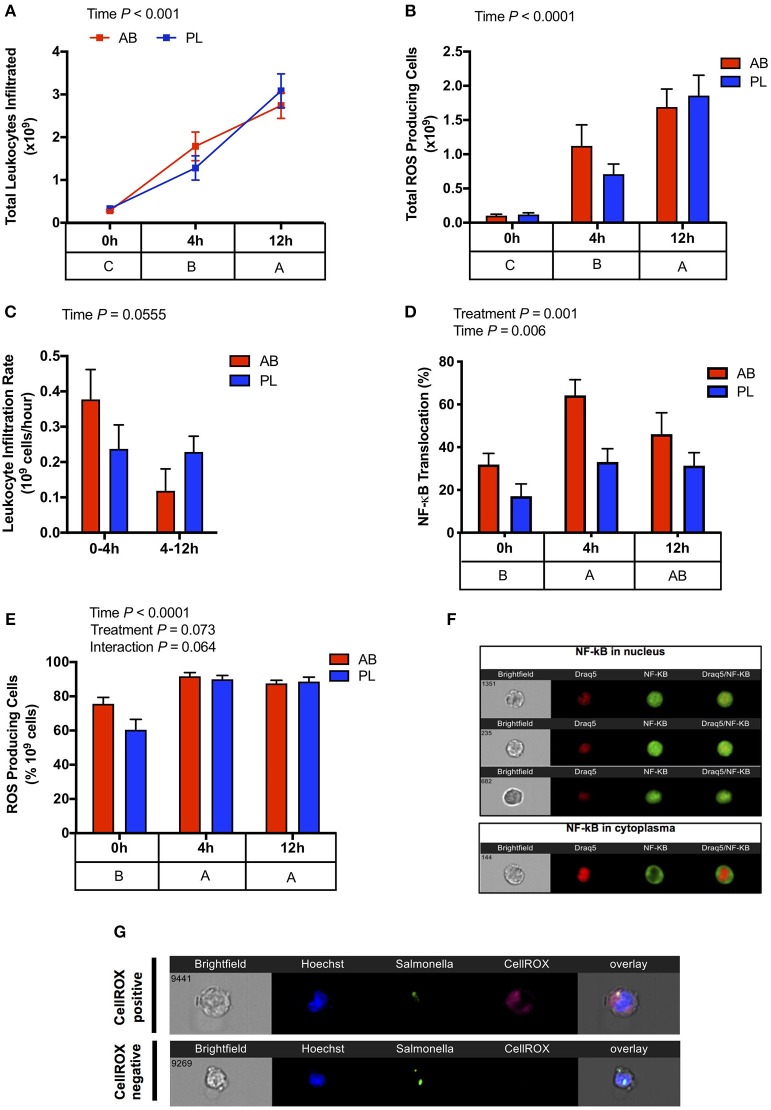
Antibiotic (AB) exposure induced a stronger leukocyte activation against an intraperitoneal Salmonella challenge in comparison to pigs treated with placebo (PL). (A) Total leukocyte infiltration (Two-way ANOVA Treatment P = 0.870, Time P < 0.001, Interaction P = 0.306) and (B) and total reactive oxygen species producing cells (Two-way ANOVA Treatment P = 0.963, Time P = 0.009, Interaction P = 0.845) increased progressively 4 and 12 h post IP Salmonella challenge. (C) Leukocyte infiltration tended to reduce over time (Two-way ANOVA Treatment P = 0.823, Time P = 0.055, Interaction P = 0.072). (D) Leukocyte activation detected through NF-κB nuclear translocation was higher in the AB treated pigs compared to PL post Salmonella challenge, and increased over time (Two-way ANOVA Treatment P = 0.001, Time P = 0.006, Interaction P = 0.410). (E) Exposure of peritoneal leukocytes in vitro to heat-killed Salmonella resulted in increased ROS production in both the AB and PL treated pigs between 0 and 4 h and 0 and 12 h with a tendency of AB treated piglets to have higher ROS production (Two-way ANOVA Treatment P = 0.073, Time P < 0.01, Interaction P = 0.064). n = 4–5/treatment/time. (F) Representative images of neutrophil NF-κB nuclear translocations (G) Representative images of ROS production in response to in vitro stimulation. The main effect of time is displayed below each figure and those PND not sharing a common subscript differ significantly.